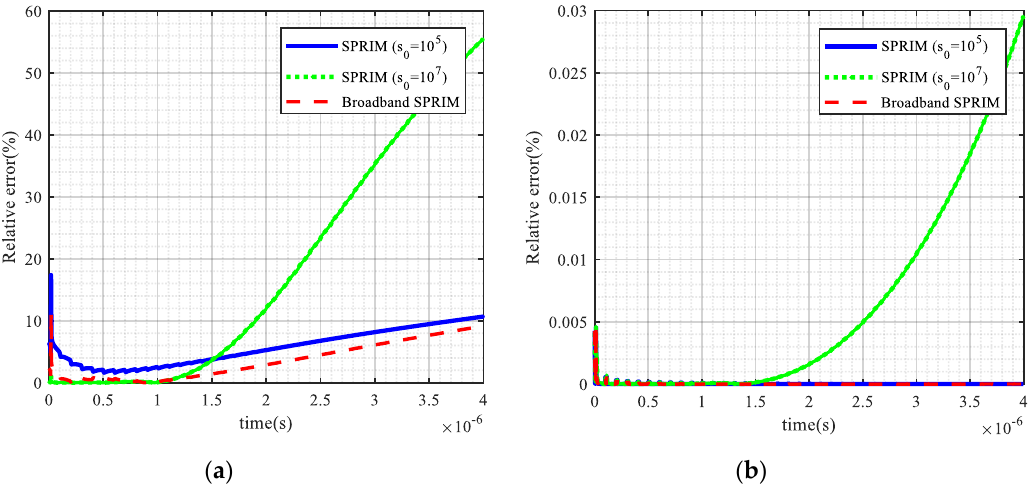
Figure 5. The transient relative errors of the output response of the reduced model of SPRIM with different expansion point s 0 and the proposed broadband SPRIM to those of the full-order circuit model under a square wave excitation of frequency f = 10 7 Hz, duty cycle = 0.1. ( a ) y1, reduced size = 12. ( b ) y1, reduced size = 18. Table 1. Relative errors of the responses for structure-preserving reduced-order interconnect macromodeling (SPRIM) and the proposed broadband SPRIM (reduced size = 12) (SPRIM1 ( s 0 = 1 × 10 5 ), SPRIM2 ( s 0 = 1 × 10 7 ), and